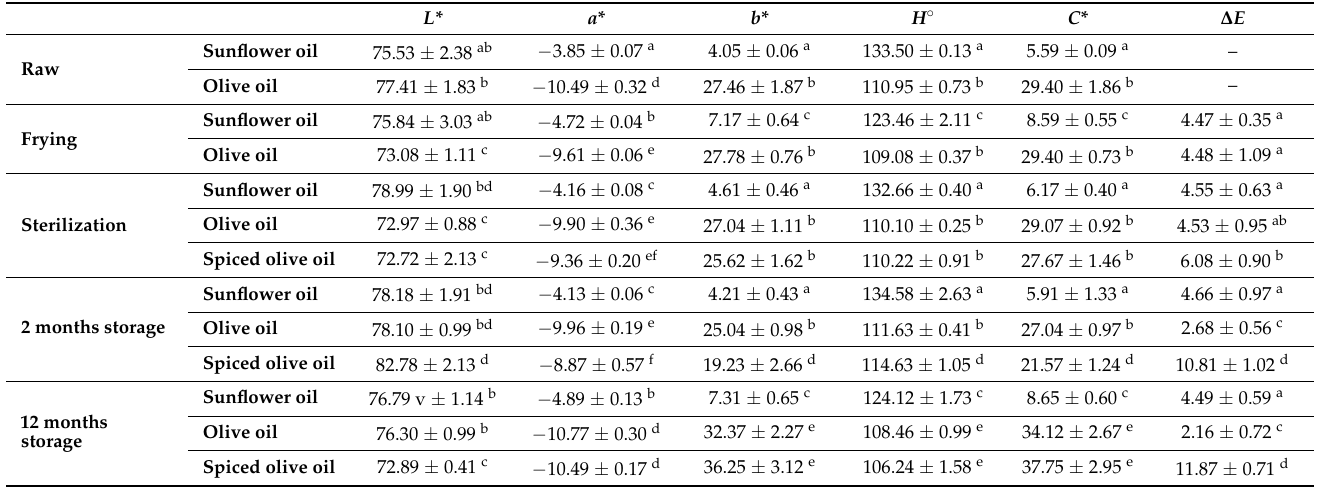
Table 3. Colour parameters in the raw oils and after each stage of processing and storage. Values are means ± standard deviations of three